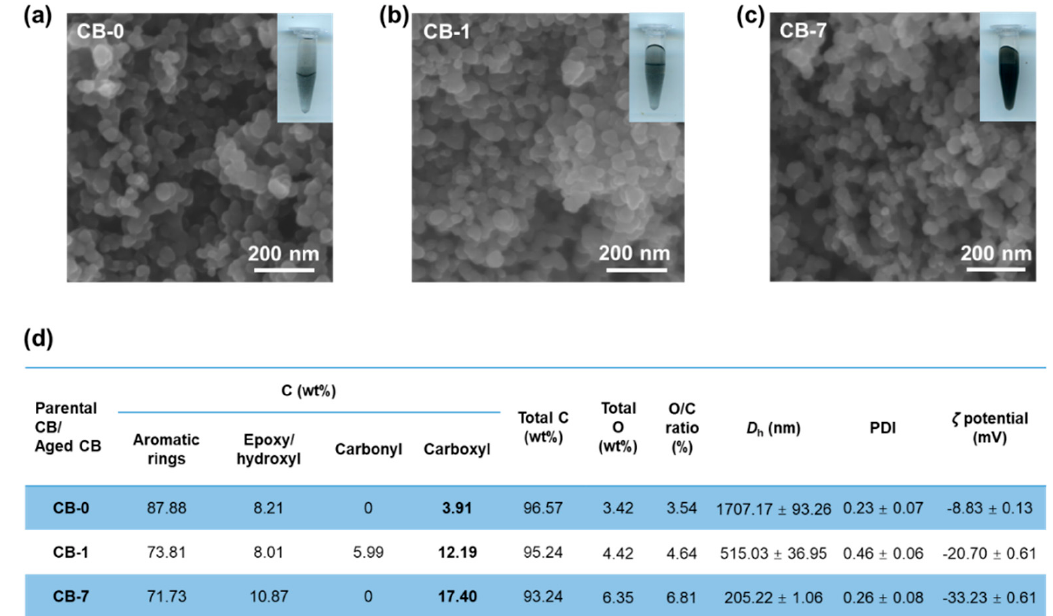
Figure 1. Characterization of parental and aged CB particles. ( a – c ) Representative SEM images of CB-0 ( a ), CB-1 ( b ), and CB-7 ( c ) particles, with inserts showing CB suspensions in DI water. ( d ) Representative physicochemical properties of parental CB and aged CB particles, D h indicates the hydrodynamic diameter on the basis of particle size distribution analysis, and PDI represents the polydispersity index (n = 3). Abbreviations: CB, carbon black; D h , hydrodynamic diameter; PDI, polymer dispersity index.